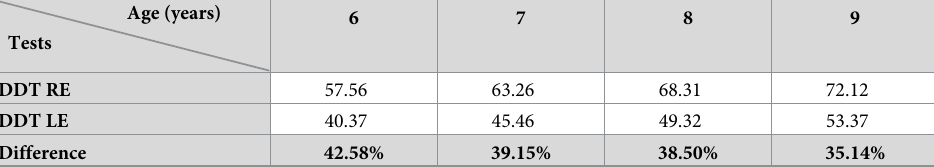
Table 13. Comparison of mean results for DDT RE and LE (dependent samples) and the percentage difference between the results for group”S”.